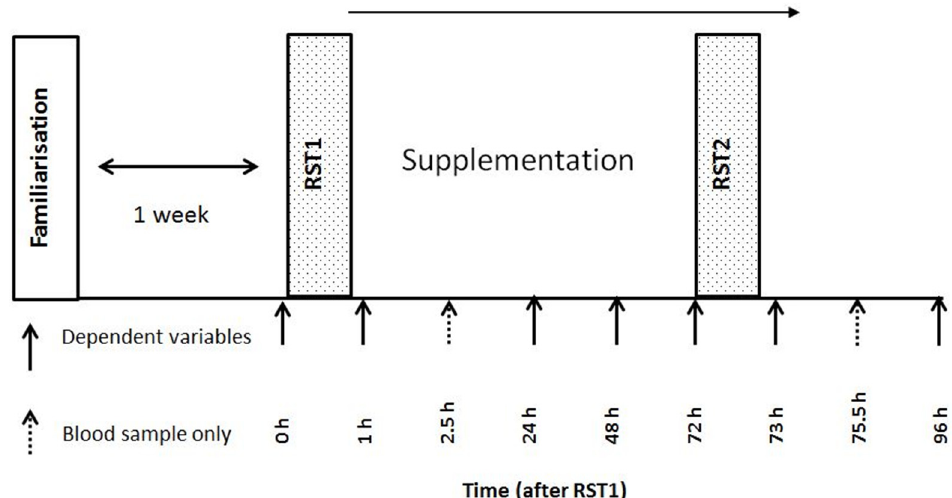
Figure 1. Schematic outline of study procedures.